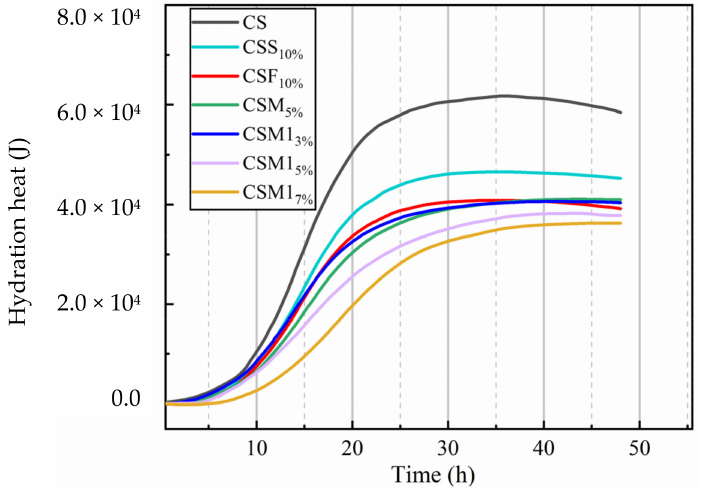
Figure 15. Hydration heat of cement slurry